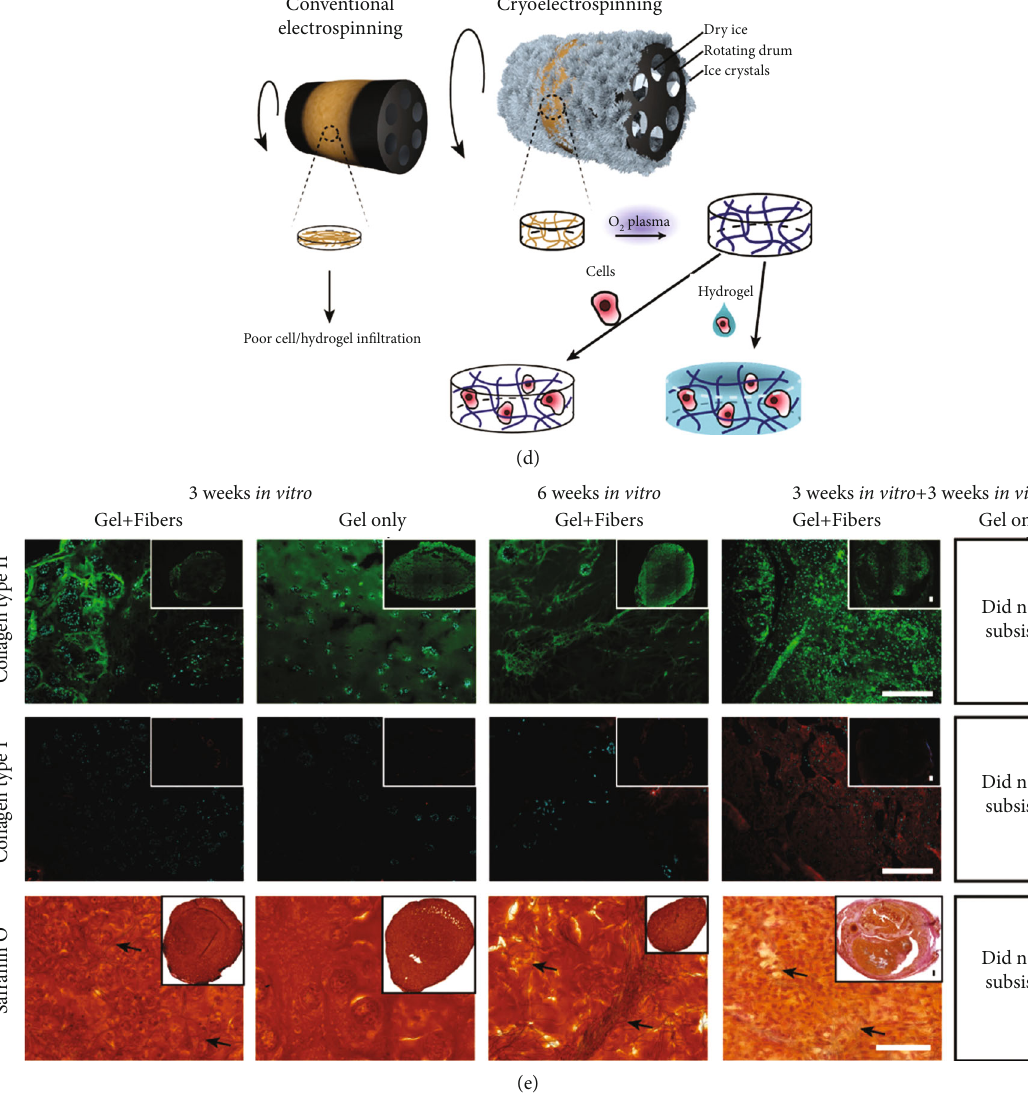
Figure 3: 3D electrospun nano fi ber-based sca ff olds for cartilage tissue regeneration. (a) The schematic illustration for fabrication and crosslinking of electrospun nano fi ber porous 3D sca ff old (3DS-1) and crosslinked with hyaluronic acid sca ff old (3DS-2). (b) The porous and fi brous structure of uncrosslinked (A, E), heat-treated (B, F), crosslinked 3DS-1 group (C, G), and 3DS-2 group (D, H). (c) Collagen type II and aggrecan immunohistochemical staining results of nontreated, 3DS-1, and 3DS-2 sca ff olds after in vivo implantation for 12 weeks. Reproduced with permission from [115]. Copyright © 2021, American Chemical Society. (d) Conventional electrospinning formed dense nano fi ber membrane. Cryoelectrospinning (on a mandrel collector at -78 ° C) induced 3D porous PCL sca ff old due to the ice crystal formation. (e) Hydrogel/nano fi ber composite constructs exhibited good chondrogenic ECM deposition and higher stability than pure hydrogel sca ff old in vitro cell culture and in vivo implantation. Reproduced with permission from [52]. Copyright © 2021, WILEY-VCH Verlag GmbH & Co. KGaA,